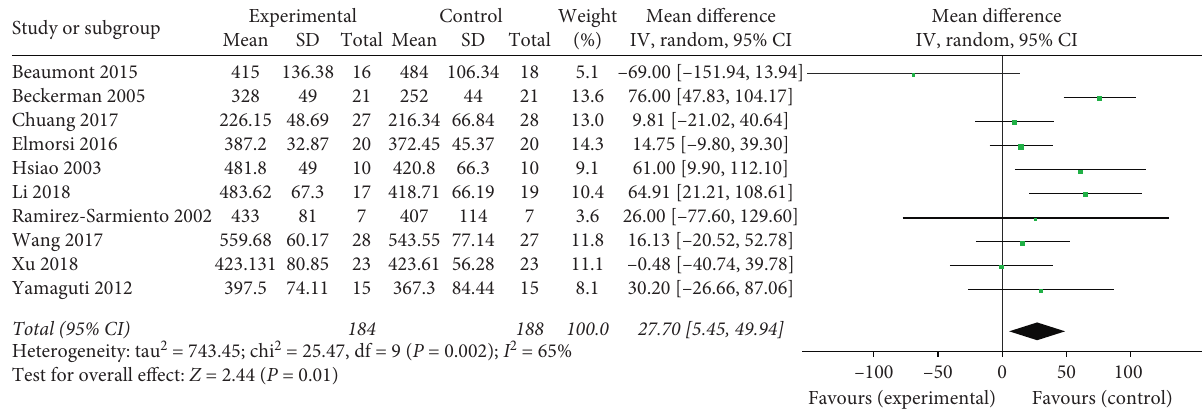
Figure 6: Effects of breathing exercises on 6MWT.